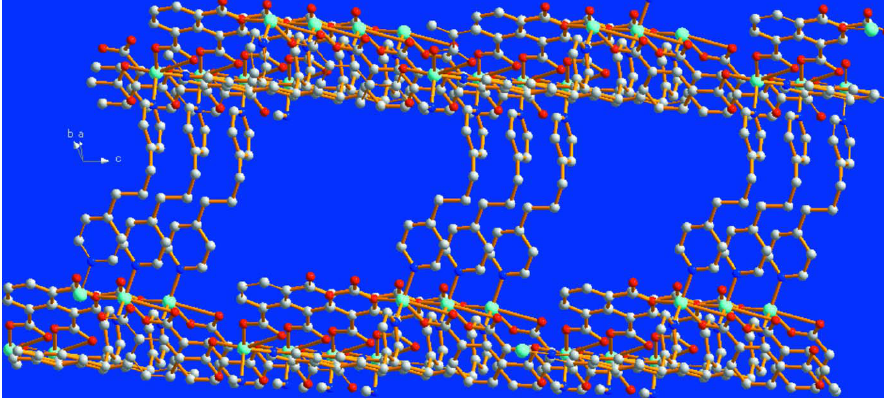
Part of the crystal structure of the title